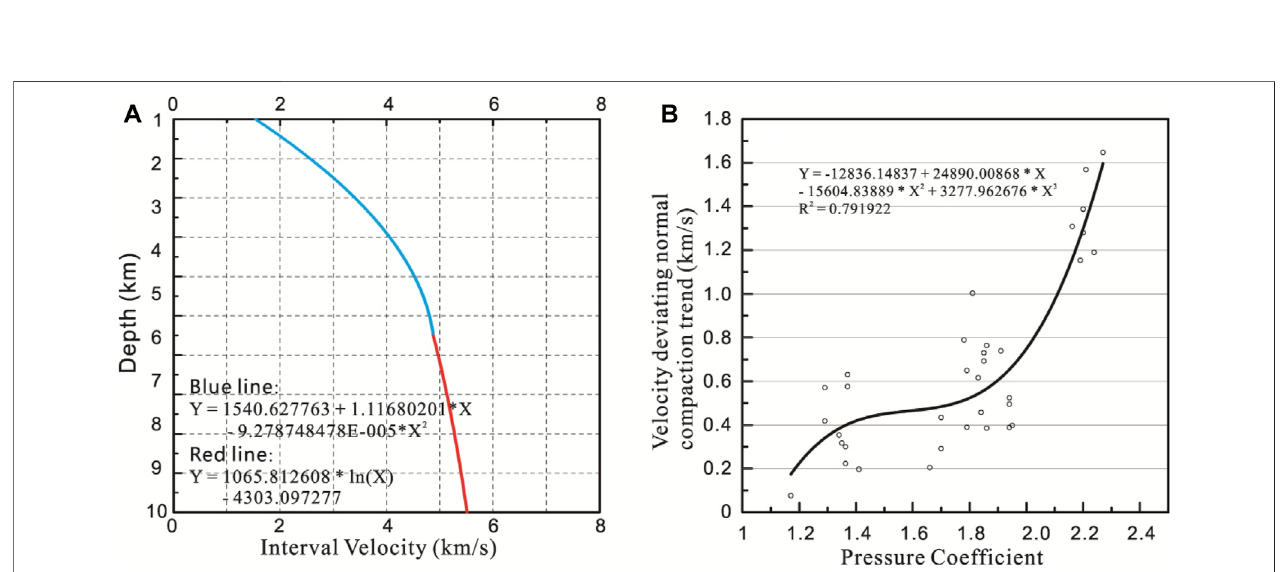
FIGURE7|(A) ReconstructednormalvelocitytrendstartingfromtheseabedthatisbasedontheP-velocitydatafrom8wellscharacterizedbythenormalpressure (blue line) and the interval velocities calculated from the stacking velocities (red line). (B) Relationship between the velocity values deviating from the normal compaction trend and the pressure coef fi cient of wells in the Qiongdongnan Basin.